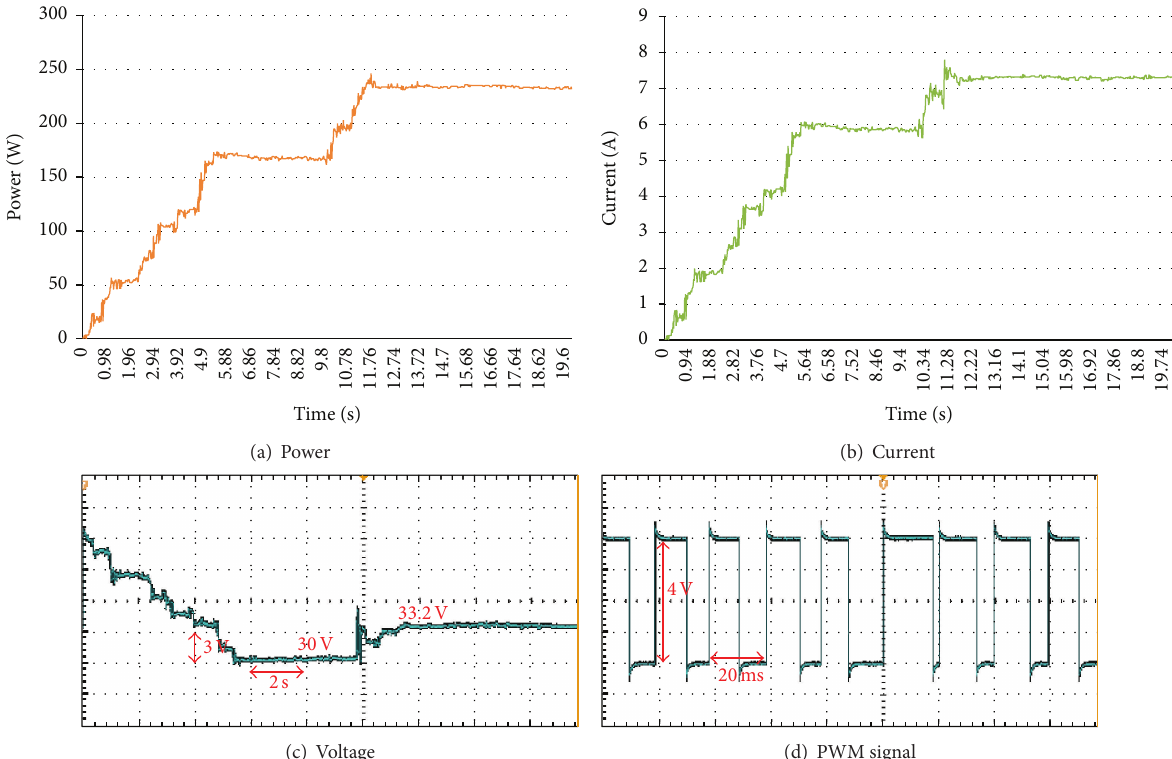
Figure 15: Tracking performance of the Newton-based extremum seeking MPPT algorithm under nonuniform